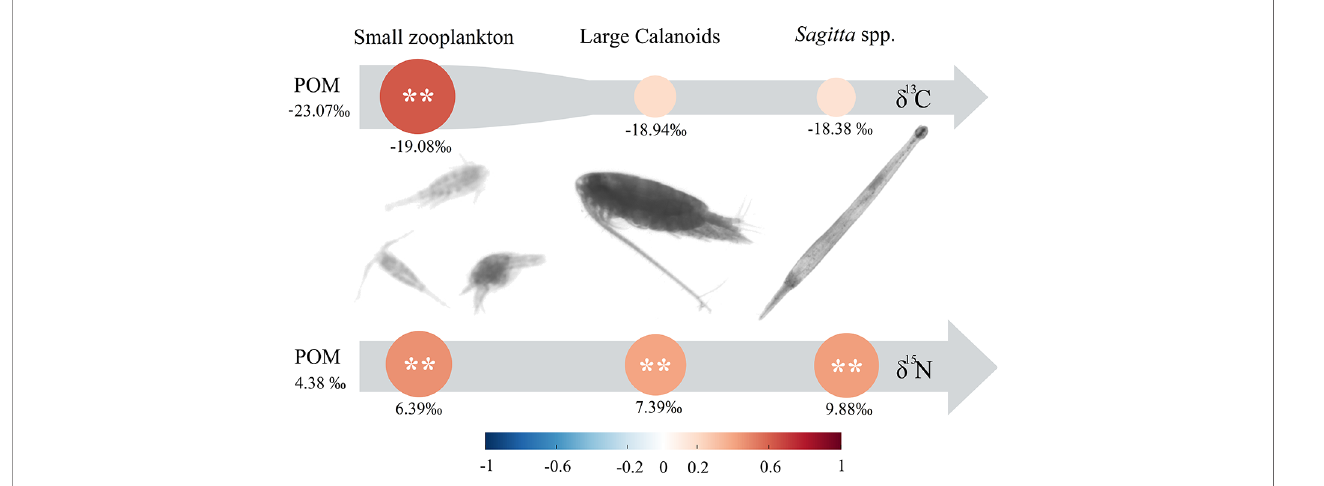
FIGURE 8 | Annual average d 13 C and d 15 N values and correlation coef fi cients between POM and dominant zooplankton groups. ** p <